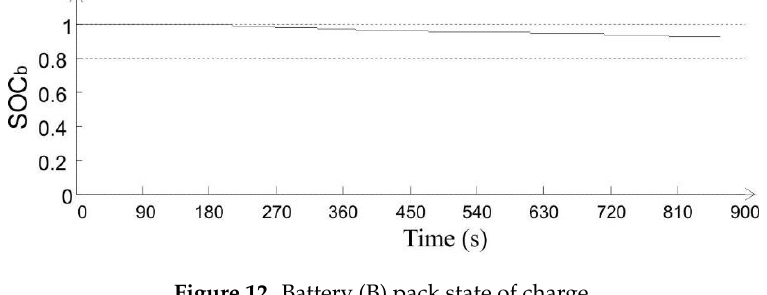
Figure 12. Battery (B) pack state of charge.